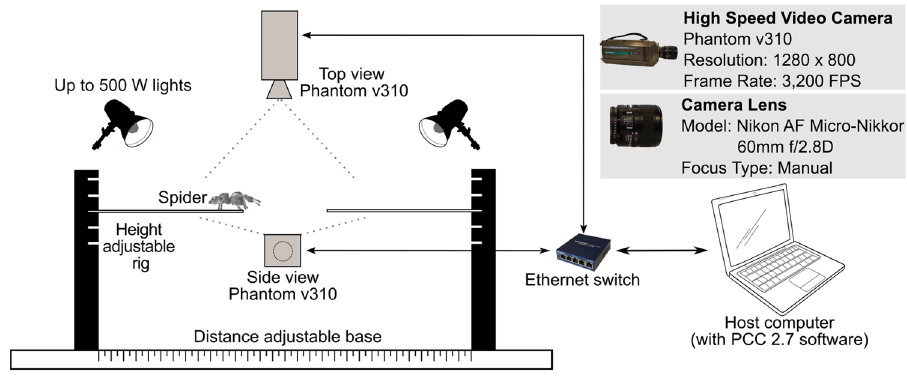
Figure 9. The jumping experiment